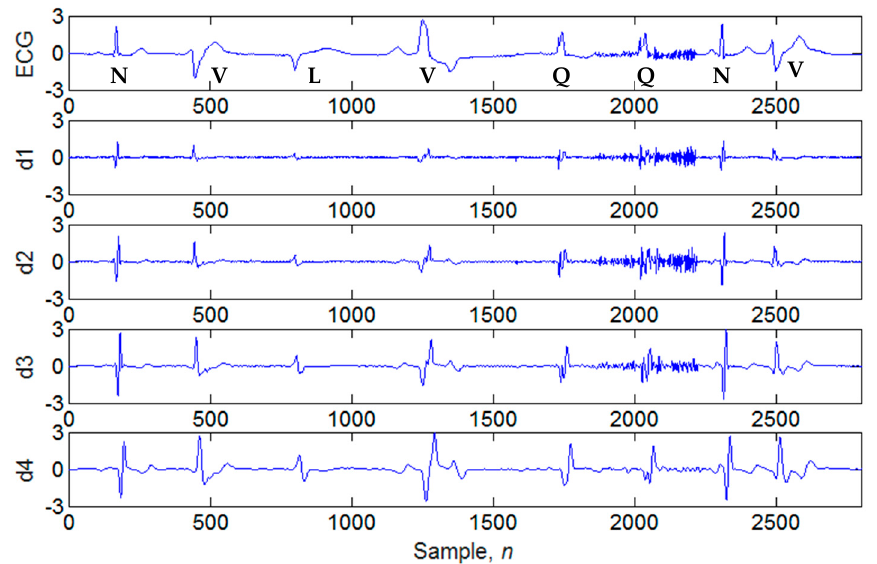
Figure 5. Illustrations of common QRS complexes and their high-frequency detail signals, d1, d2, d3, and d4. N: Normal beat; V: Premature ventricular contraction beat; L: Left bundle branch block beat; Q: Unclassifiable beat.